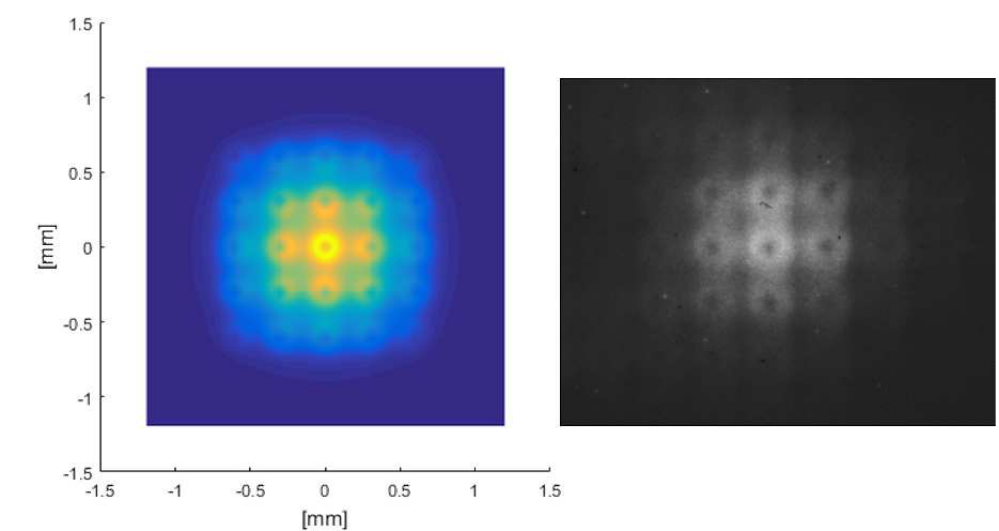
Figure 10. Comparison between a Zemax simulation ( left ) and a typical experimental measurement ( right ) [24].